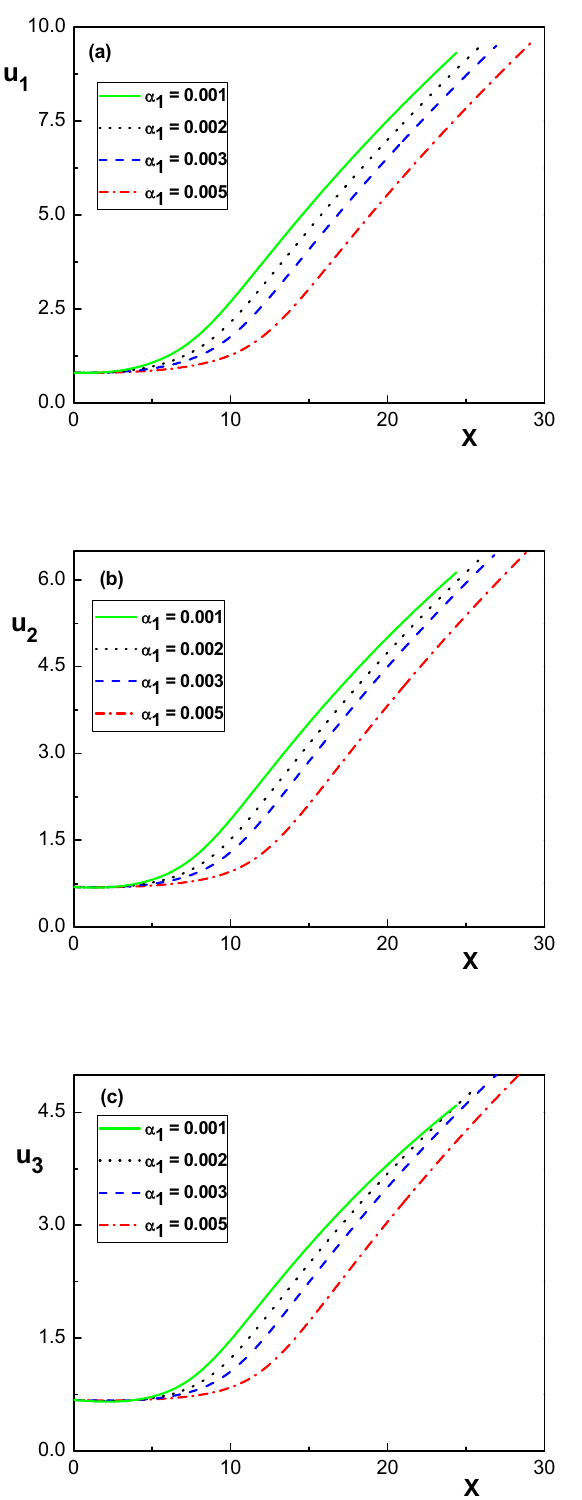
Figure 8. Variation of the normalized ion velocities versus the normalized distance from the sheath edge for different values of α 1 . The same parameters as in Fig.